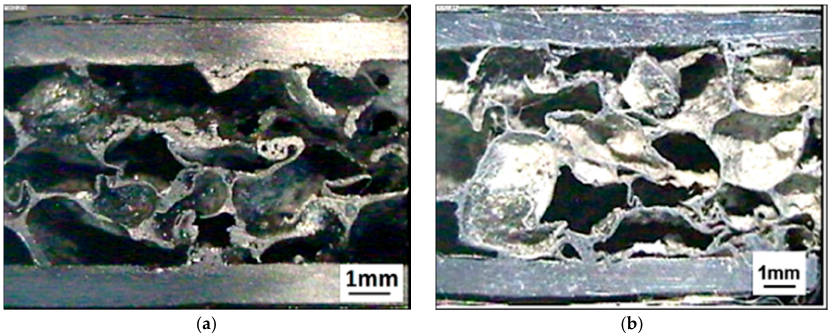
Figure 3. Macrographs of polished cross-sections of AFS specimens produced using ( a ) Al-Cu-Mg amorphous alloy; and ( b ) using Al-Si-Mg-Ti amorphous alloy.